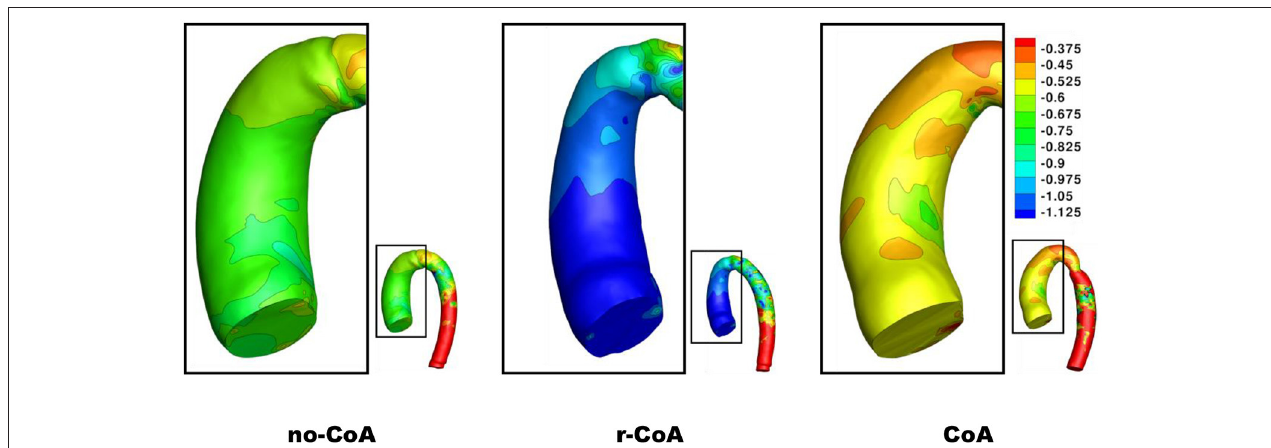
FIGURE 4 | Contour of pressure (mmHg) on the ascending aorta at end systole.